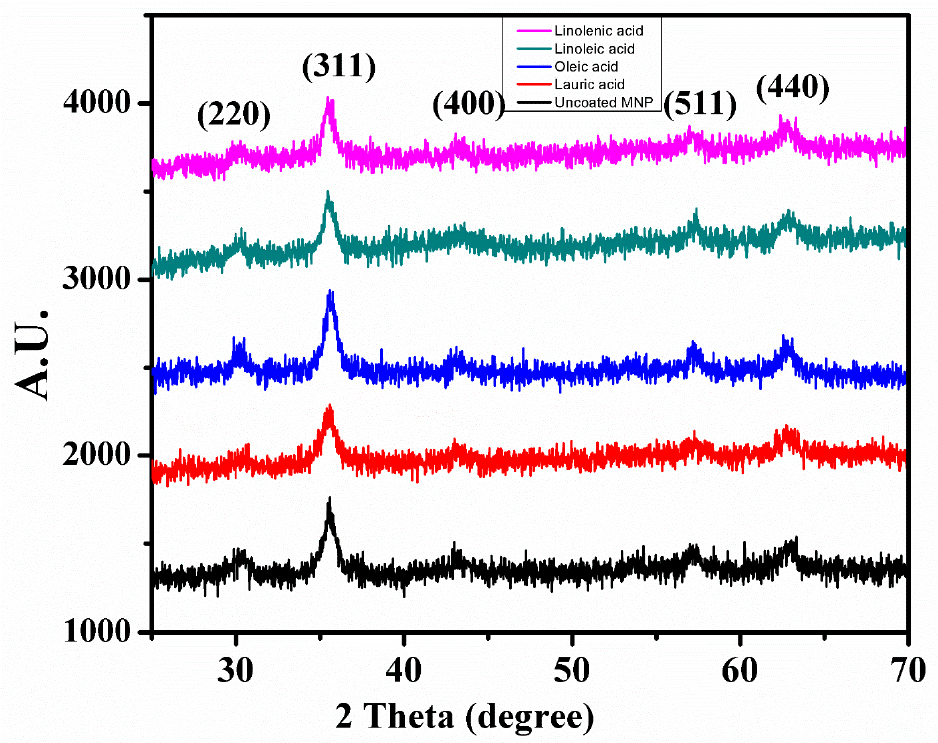
Figure 4. EM images of ( a , b ) uncoated MNPs, ( c ) lauric-acid-coated MNPs, ( d ) oleic-acid-coated